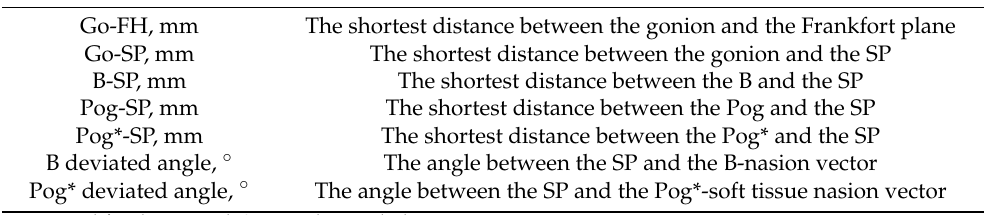
Figure 3. The process of virtual planning and 3D-printed template design. ( a ) The original maxilla, mandible, and condylar OC; ( b , c ) designed DOS, DOT, and adjust direction of the osteotomy plane in the position of the rotated mandible; ( d – f ) the co-point of the non-OC-affected side was set as the rotation center to roll the mandible in a 3D view; ( g – i ) rotation center in 2D view and measurements of osteotomy depth (gray arrow — DOS; red arrow — DOT; green arrow — osteotomy plane; blue ar- row — rotation center). 2.5. Facial Morphology Simulation The mandible and chin were deviated to the non-OC-affected side before surgery, and the facial morphology was also deviated owing to the existence of OC. When the OC was removed during virtual surgery, the affected side condyle went back to the articular fossa, according to final occlusion. The maxilla was not changed in this position; however, the mandible and chin were moved to near the midsagittal plan; thus, the facial morphol- ogy was also changed. Therefore, the soft tissue simulation was performed to predict fa- cial morphology after OC removal in virtual surgery. The video is available in the Sup- plement Files (Video S1). 2.6. Surgical Procedures Surgeries were performed under general anesthesia through nasal endotracheal in- tubation. The L shaped pretragal incision was made, incising the tissue in layers to expose the condylar surface. According to the preoperative plan, the DOS was first used to fit the occlusion with a wire fixation; in this step, an adequate dose of muscle relaxants was re- quired. When the osteotomy boundary was clearly exposed, the DOT was located in the steady joint space. The osteotomy line was obtained using a reciprocating saw using the 3D-printed template, through which the direction and measured osteotomy depth were determined preoperatively. Then osteotome and round drill were used to remove the con- dylar OC and trim the edge of osteotomy (Figure 4). When the tumor with the affected condyle was completely removed, the DOS could be removed. No remarkable bleeding